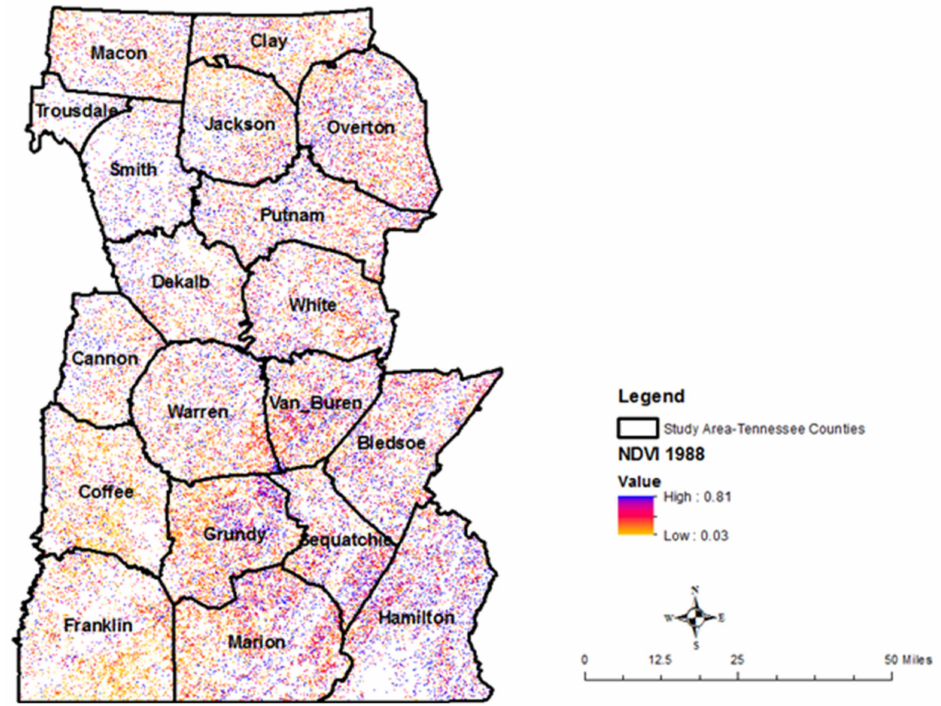
Figure 6. December 1988 Normalized Difference Vegetation Index (NDVI) of southern yellow pines.